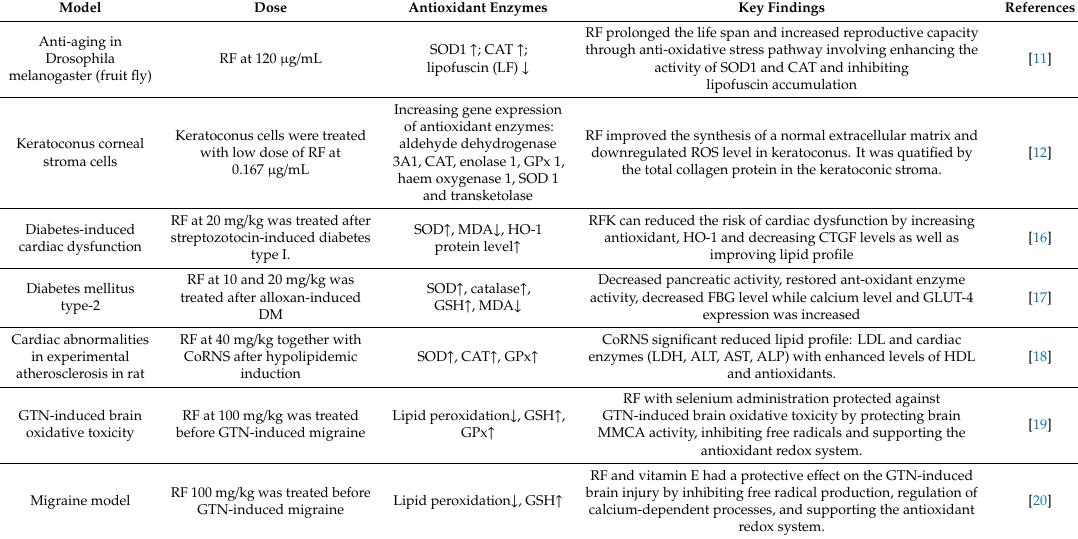
Table 2. Evidence on effect of RF and its roles for reactive oxygen species in various symptoms and diseases. Upregulation ↑ , downregulation ↓ .